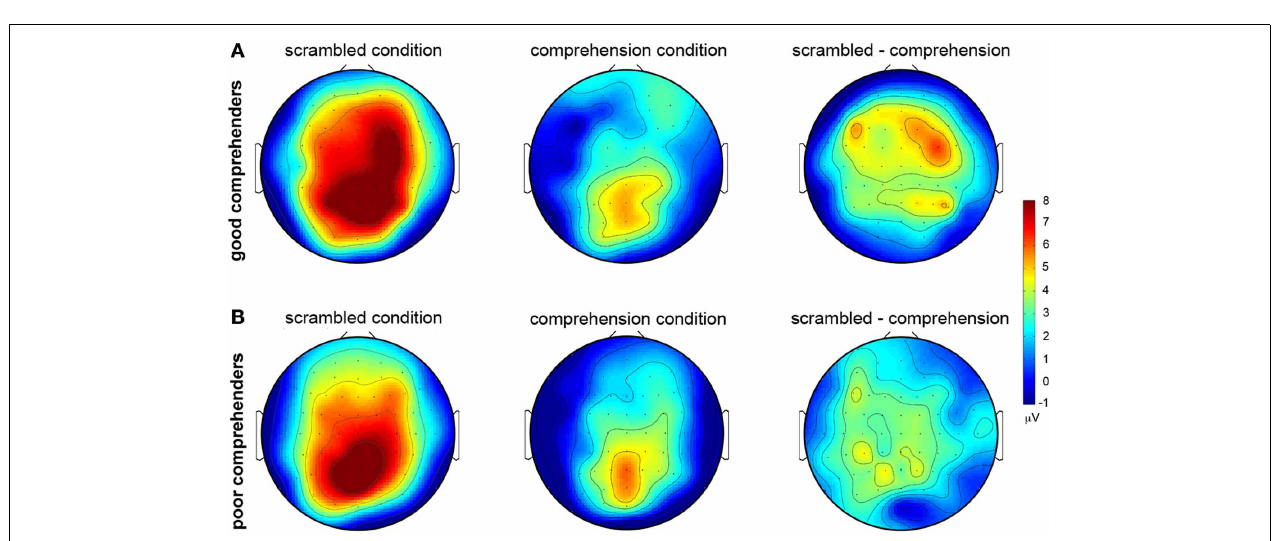
indicate greater positive voltages (see color bar to the right of the figure). Left column: scrambled condition. Middle column: comprehension condition. Right column: difference map (scrambled condition minus comprehension condition).